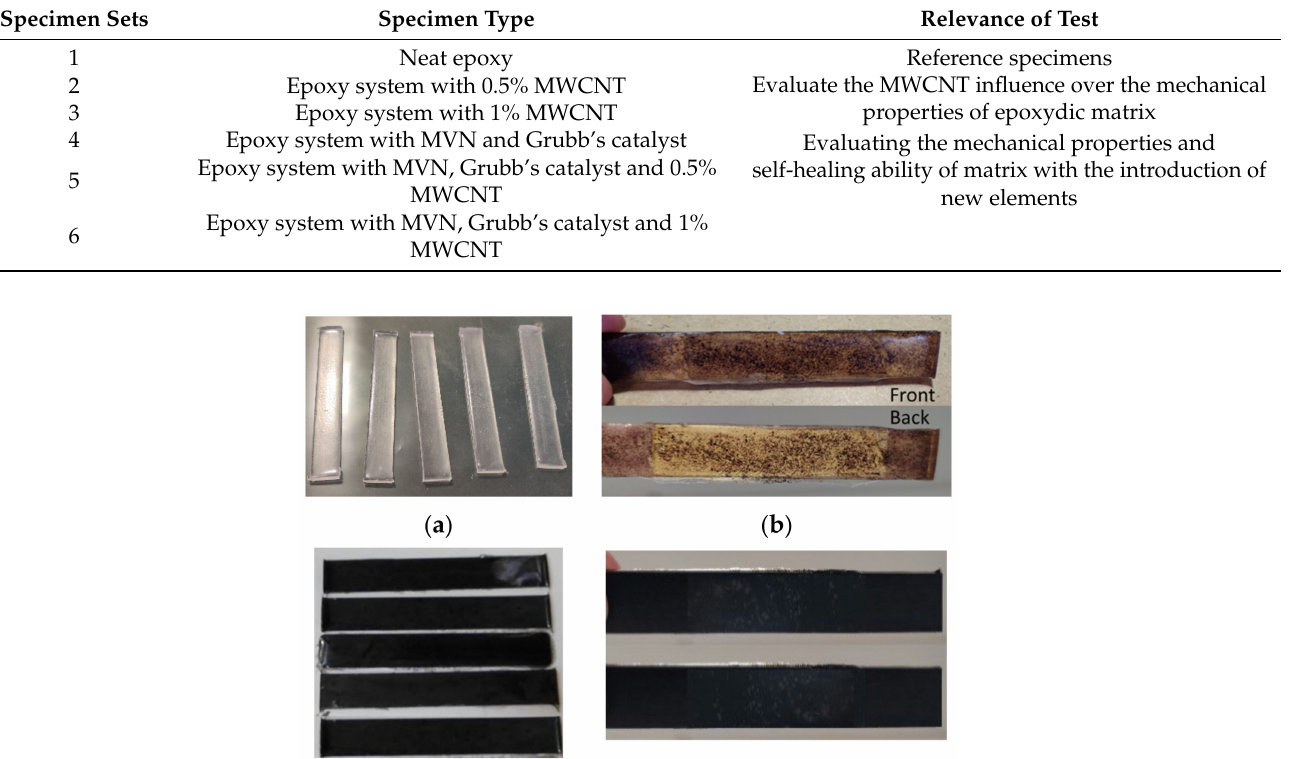
Table 3. Epoxy resin specimen to be tested.